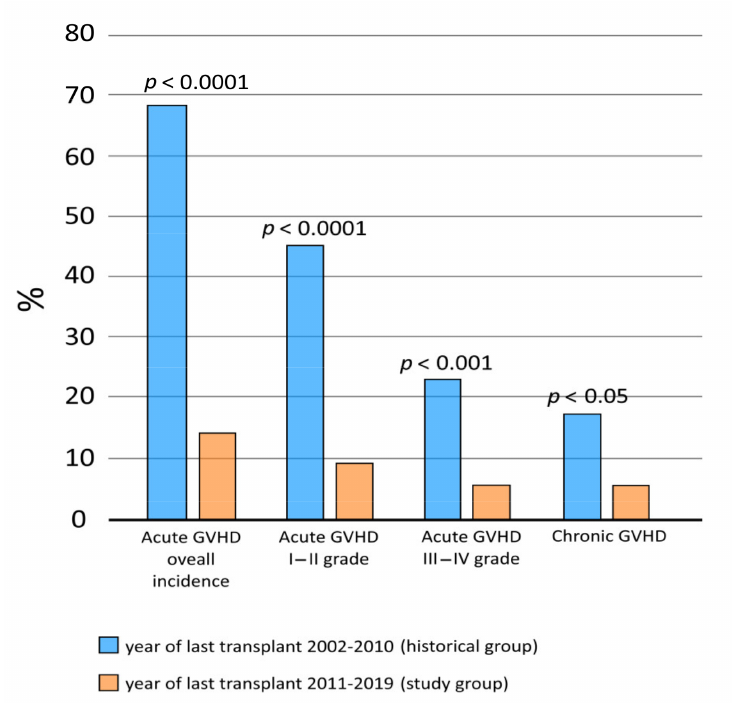
Figure 1. Incidence in the study group and the historical group of overall acute graft-versus-host disease (GvHD), acute GvHD with respect to different grades, and overall chronic